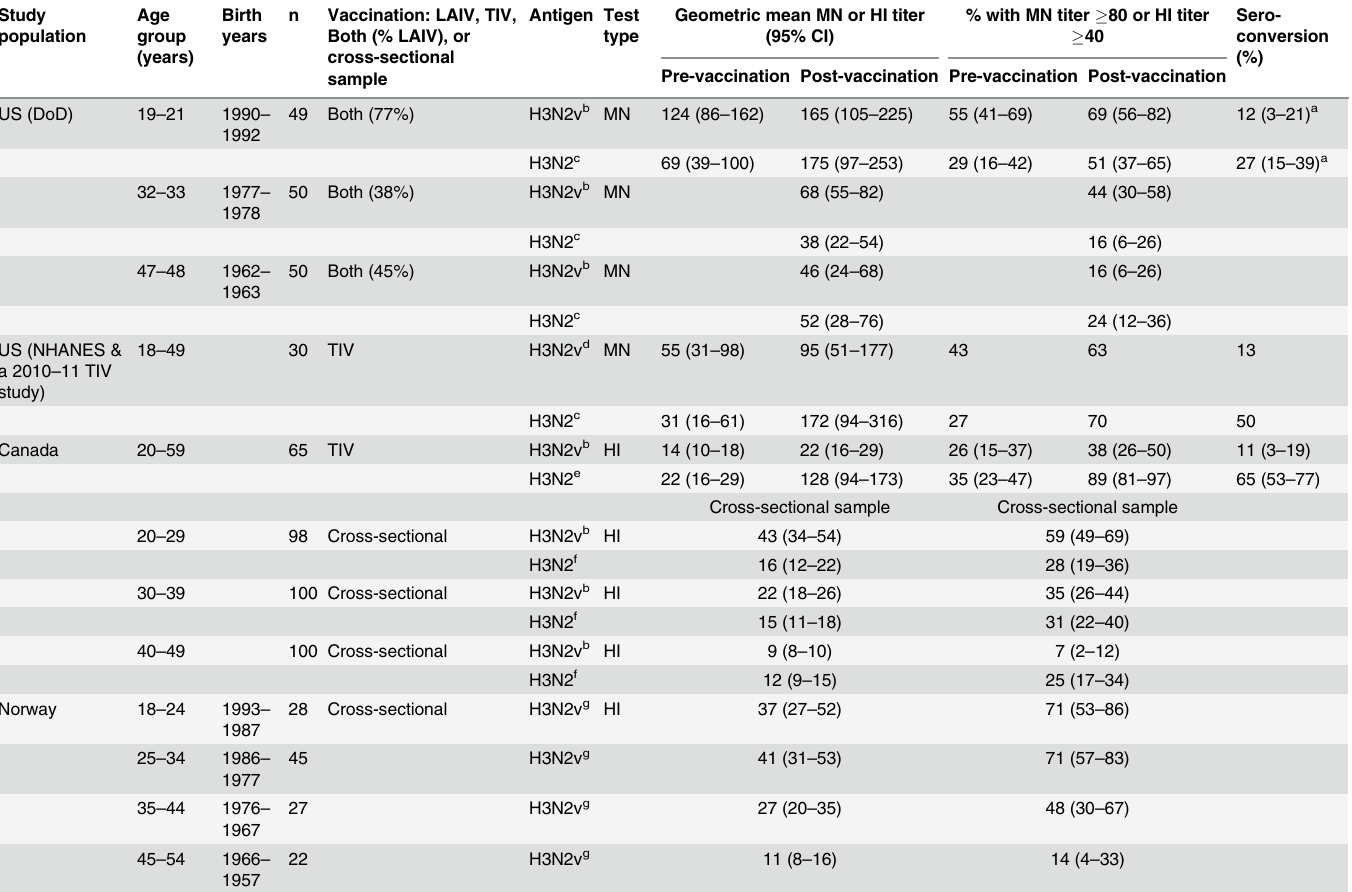
Table 1. Geometric mean titer, percentage with microneutralization titer (cid:1) 80 or hemagglutination inhibition titer (cid:1) 40, and seroconversion, by age group and selected summary of previous studies with similar age